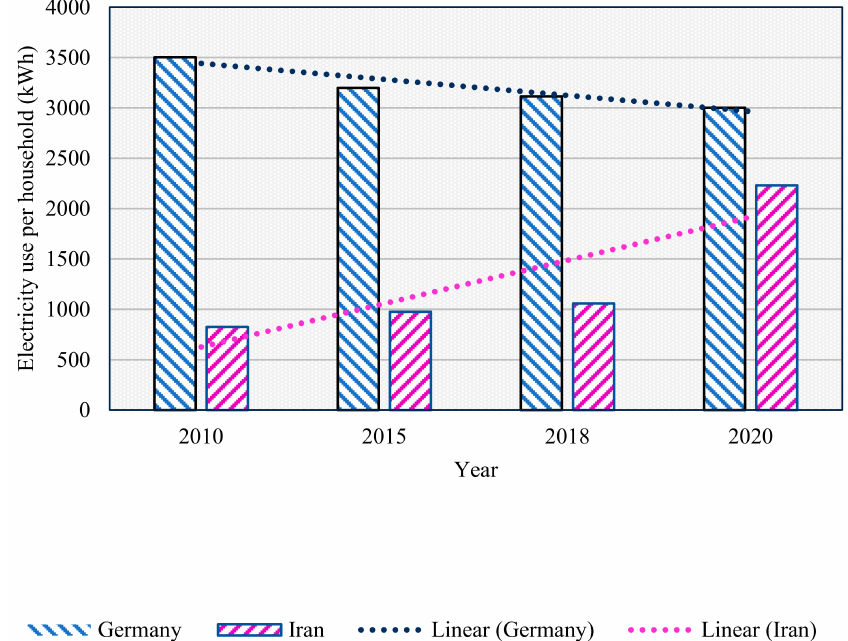
Figure 10. Electricity use per household in Germany versus Iran.